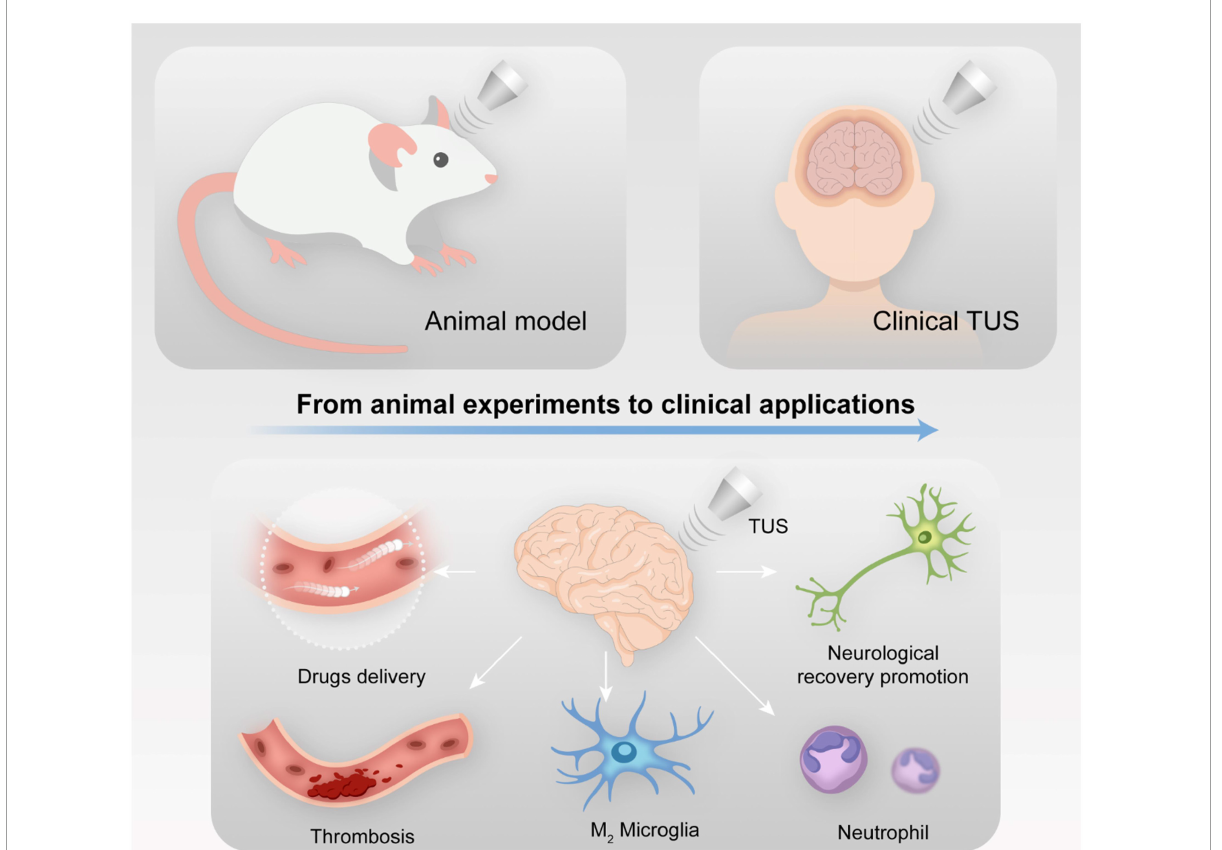
FIGURE1 The mechanism of transcranial ultrasound stimulation (TUS) in stroke rehabilitation.